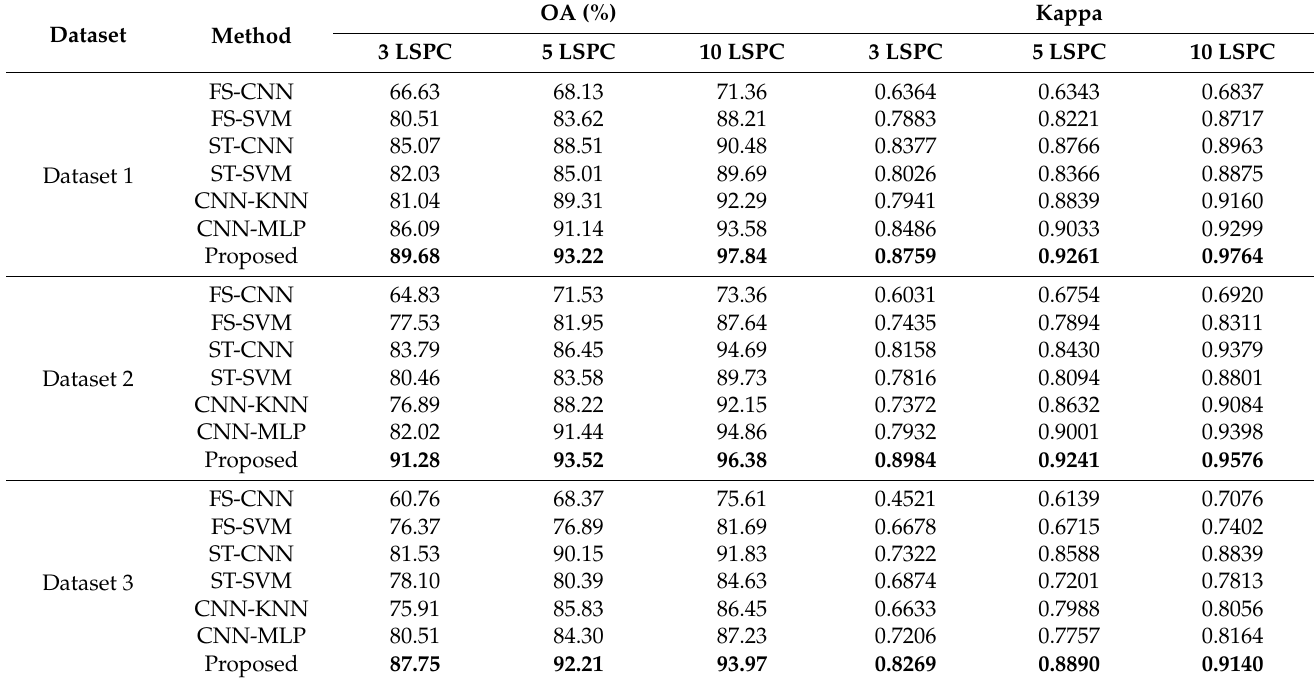
Table 1. OA (%) and Kappa coefficients of datasets 1–3 given by seven